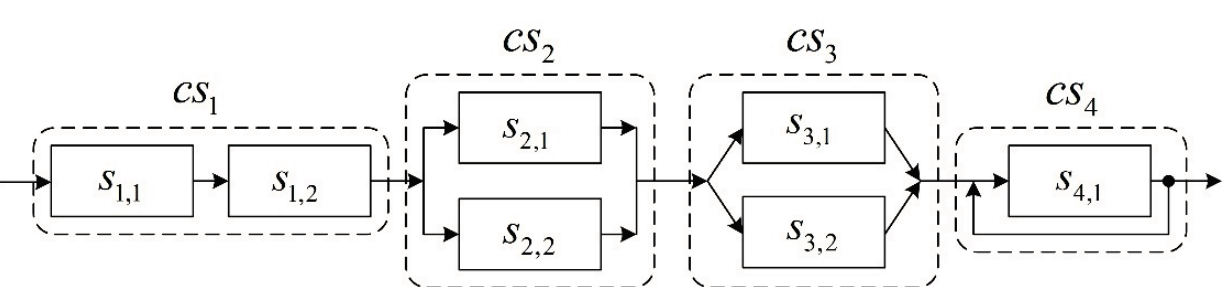
Figure 6. A numerical example.